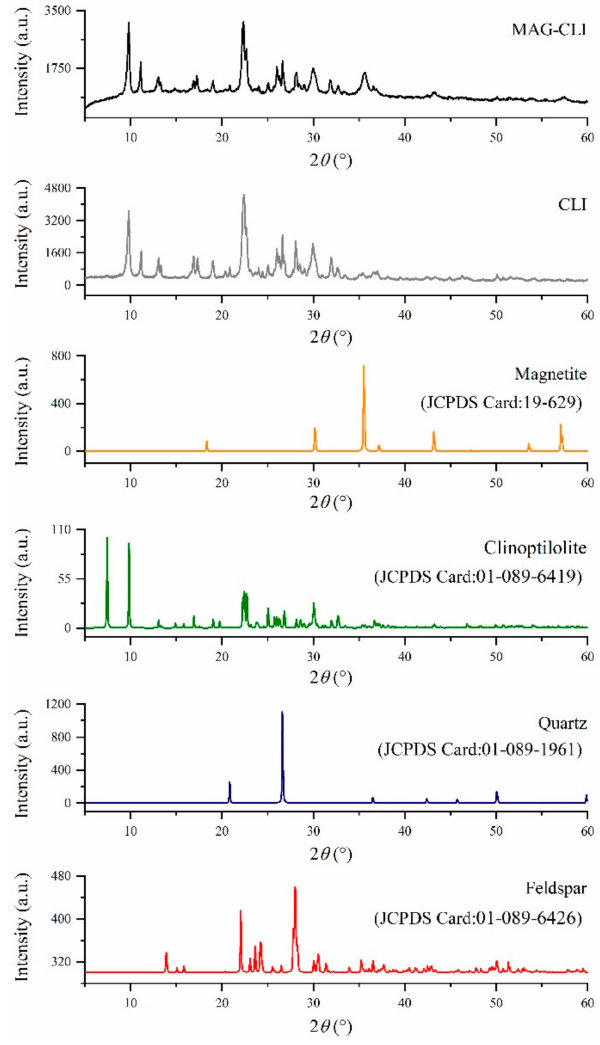
Figure 2. PXRD patterns of CLI and MAG-CLI. Table 2. The average chemical composition of the CLI phase of CLI and MAG–CLI obtained by EDS